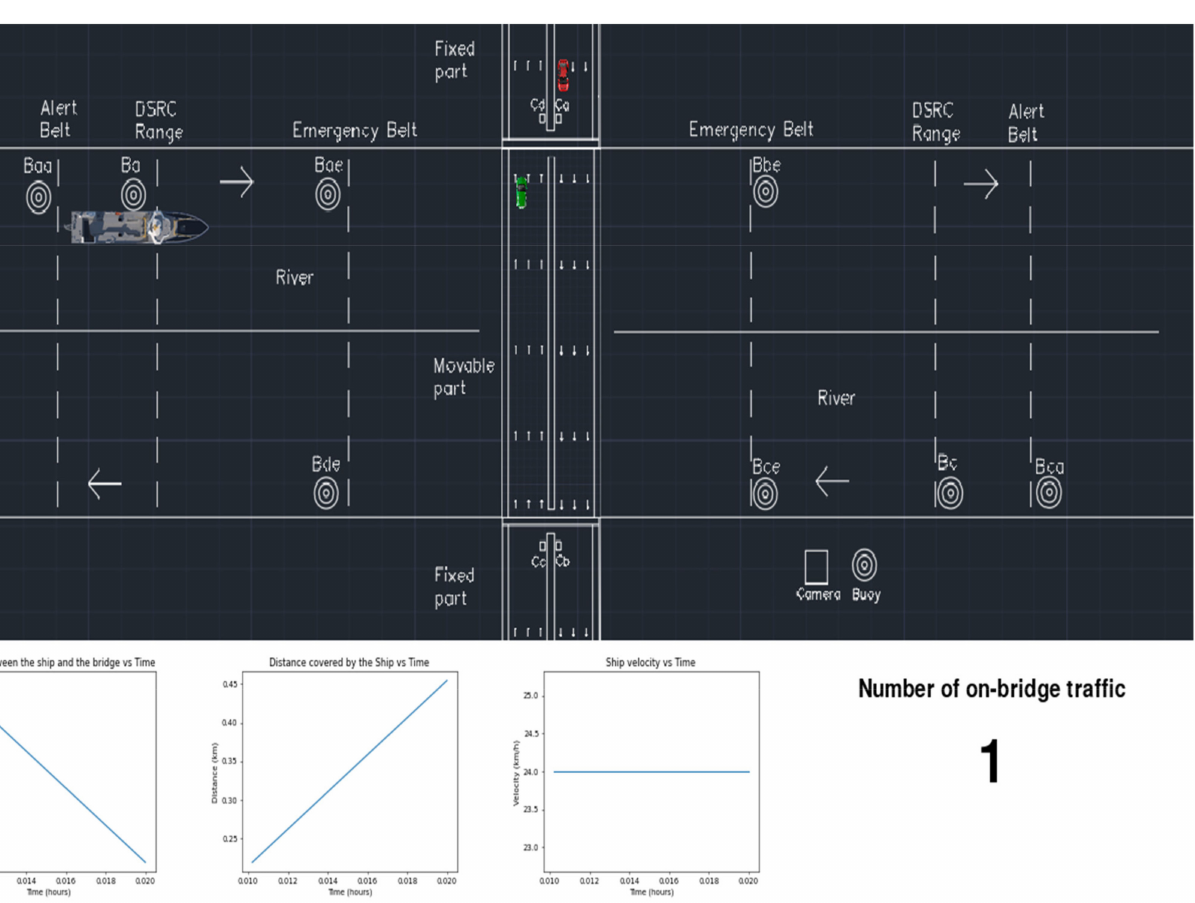
Figure 12. Ship detection scenario at DSRC range and impromptu bridge